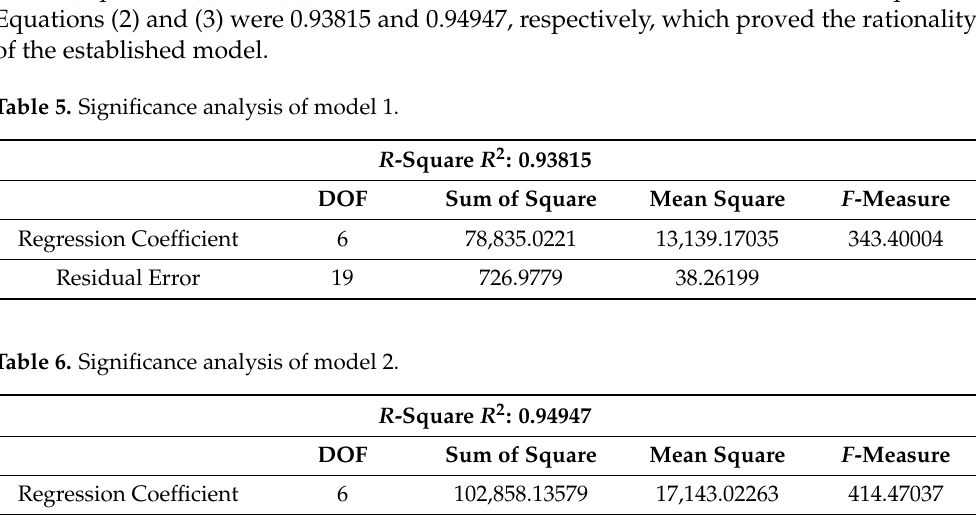
Table 6. Significance analysis of model 2.